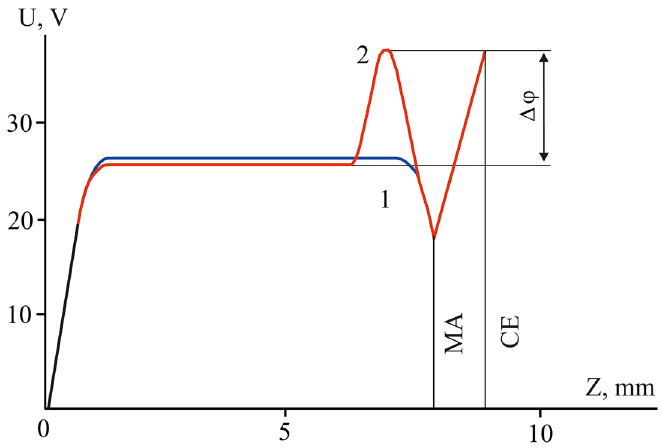
Figure 4. Potential distribution over the gap of the experimental device at helium pressure P He = 2.5 Torr; currents at the CE i ce , A: 1–0; 2–0.04.